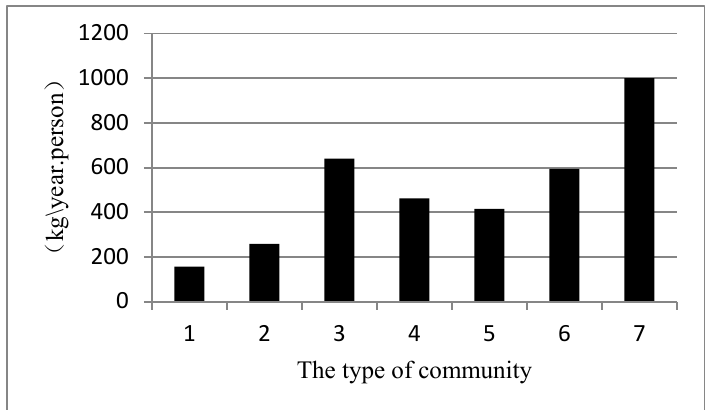
Figure 5. Travel carbon emissions of residents in different types of communities. Notes: 1. core area new garden community, 2. core area old residential area, 3. core area unit compound, 4. central district new garden community, 5. central district old residential area, 6. central district unit compound, 7. new garden community in outer suburbs.